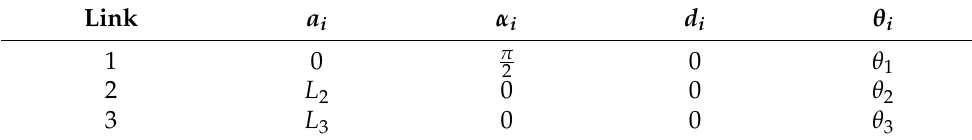
Table 2. DH parameters for the leg.